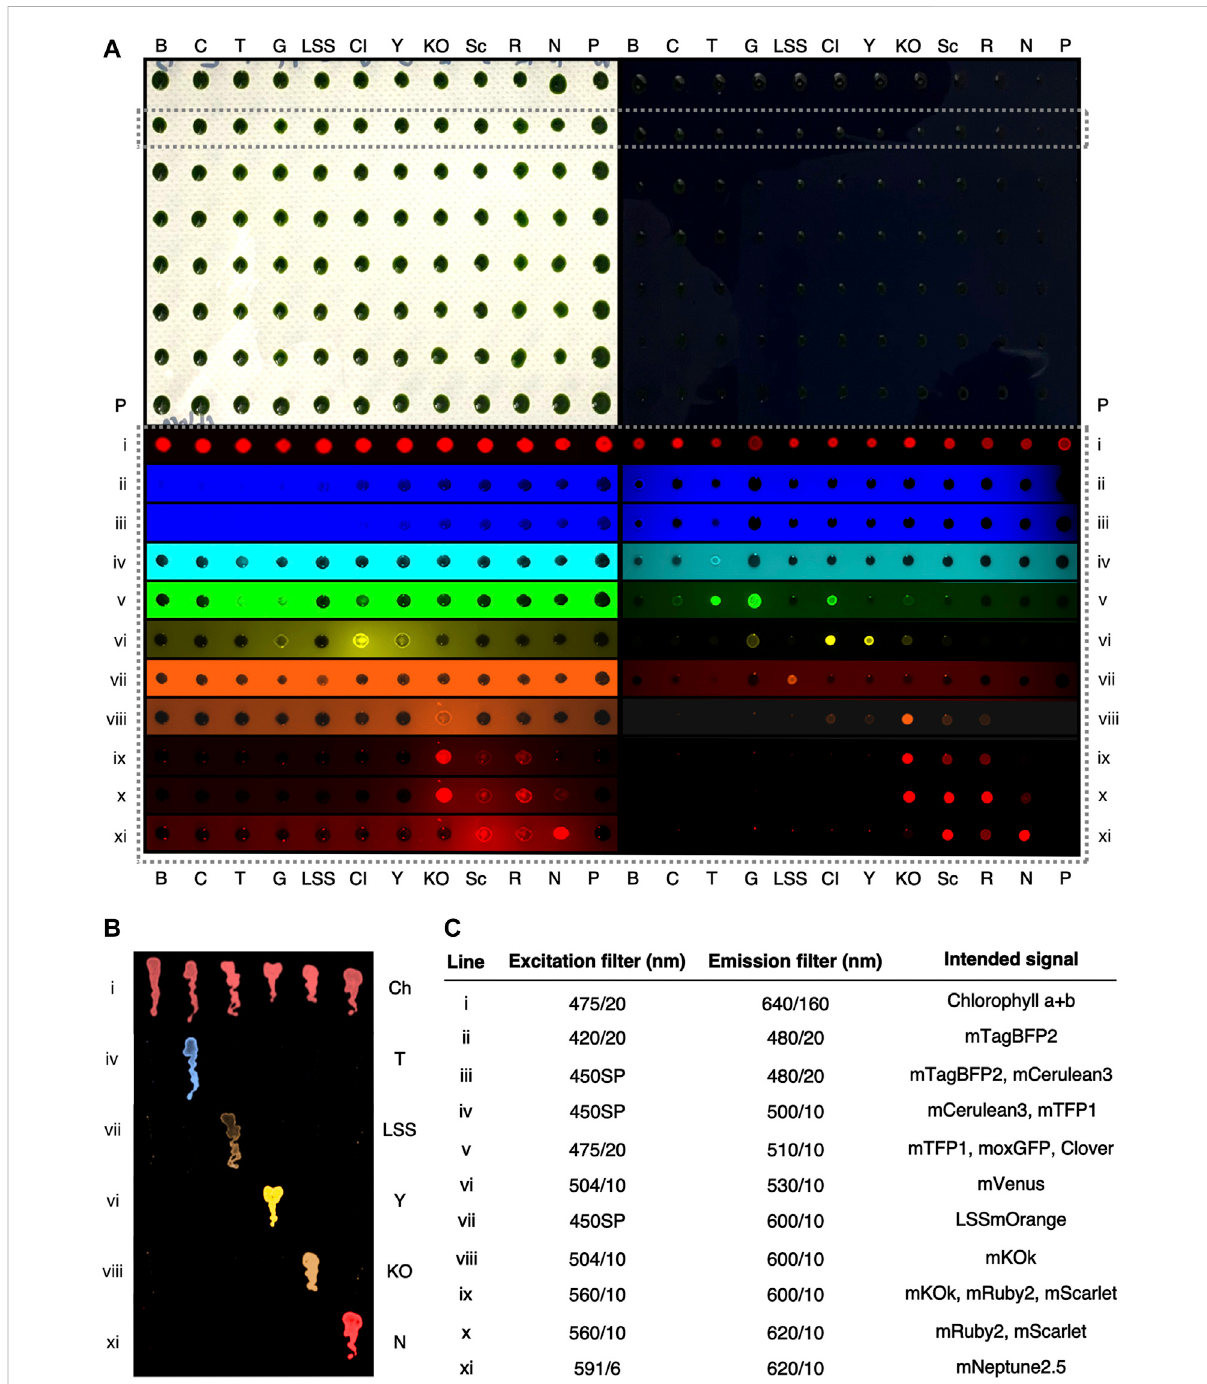
FIGURE 2 Representative fl uorescence behaviors C. reinhardtii colonies expressing different fl uorophores at the agar plate level. (A) — A digital camera color image of two 96-colony orientation agar plates of C. reinhardtii cells. Plates are stamped replicas of each other, with the right plate containing 150 mg L − 1 amido black in the medium. (B) mTagBFP2, (C) — mCerulean3, T — mTFP1, G — moxGFP, LSS — LSSmOrange, Cl — Clover, Y — mVenus, KO — mKOk, Sc — mScarlet, R — mRuby2, N, mNeptune2.5, P — parent strain. A single row (dashed box) is highlighted and signals from this row shown after excitation andemission imagingwith theindicated fi lters(i-xi). Colors have been digitally added to greyscale images by theVisionWorks software.Bothplateswereimagedsimultaneouslywiththeindicated fi lters. (B) Anamidoblackplatewithstreaksof C.reinhardtii coloniesexpressing individual fl uorescent proteins and imaged with the indicated fi lters colour has been digitally added to greyscale images. Ch — chlorophyll a+b auto fl uorescence. (C) fi lters used in (A,B) and their intended fl uorescent protein